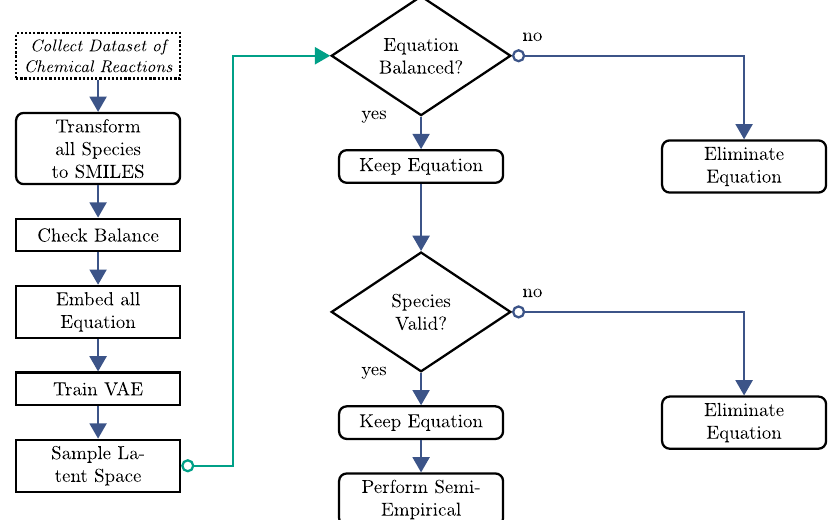
Fig. 2 Flow diagram of the data collection, training, and validation steps taken by AGoRaS to generate synthetic data. The generated equation is checked for both balance and existence. The semi-empirical calculation receives a SMILES descriptor and conducts an independent series of processes to generate a clean atomistic description prior to calculation of thermodynamics